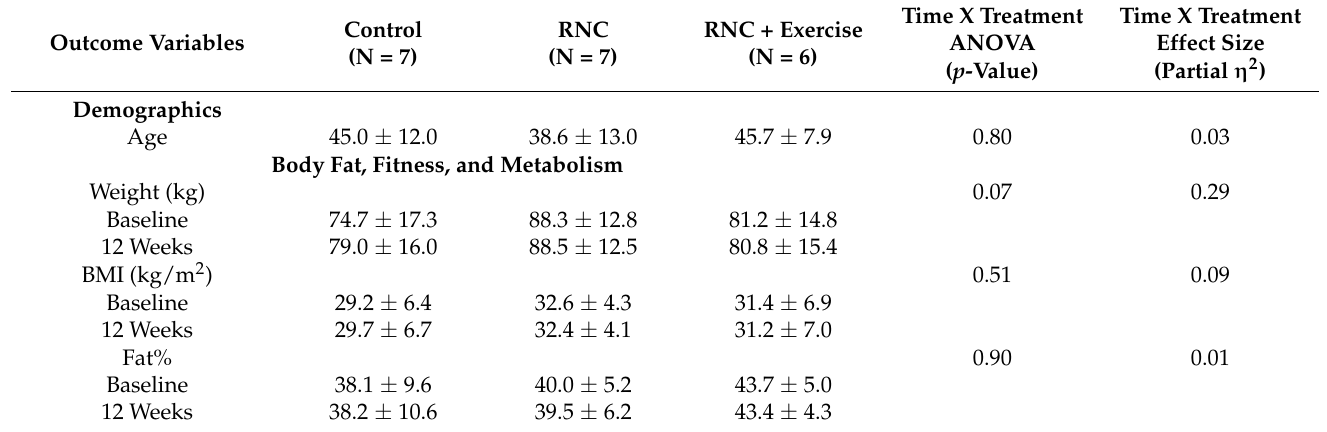
Table 1. Effect of RNC with or without Exercise on cardiometabolic